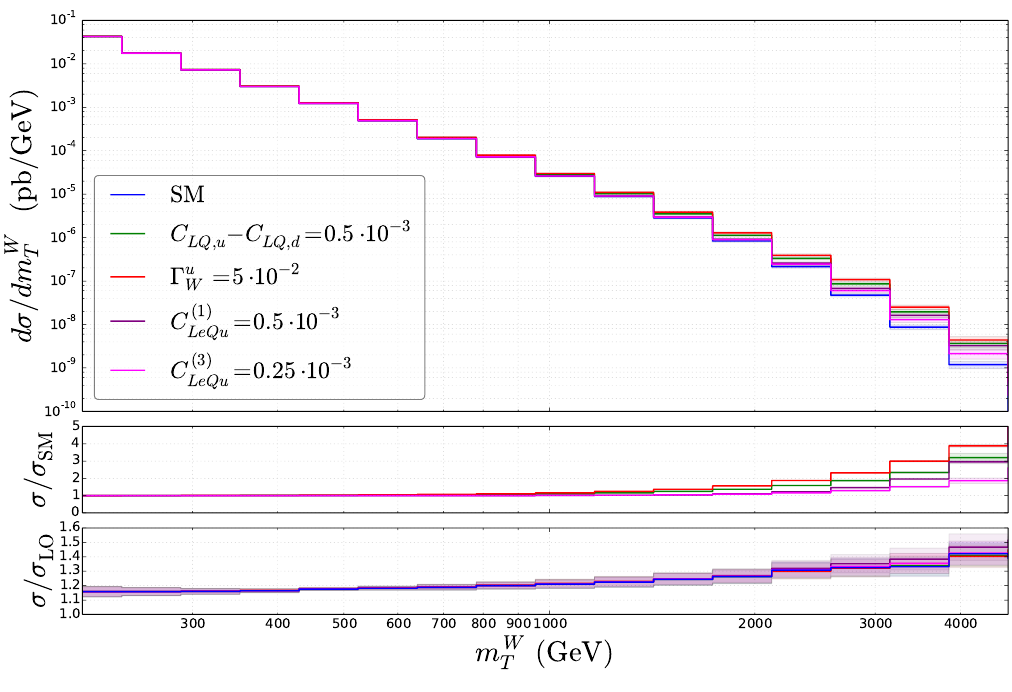
p , at S = 13 TeV. T